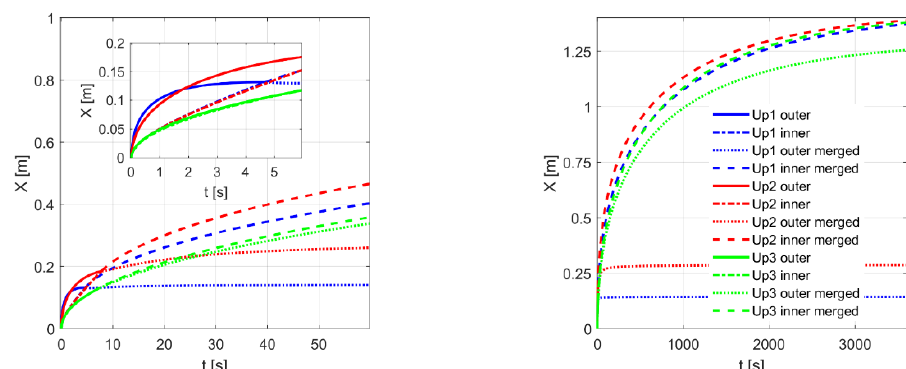
Figure 9. The height of water column [m] as a function of time [s] for cases Up1, Up2 and Up3, listed in Table 2. The graph panels represent two time intervals, 0–1 min and 0–1 h, respectively. The blue, red and green curves represent cases Up1, Up2 and Up3, respectively. Dashed and dotted lines represent the height of the water column after the merging of fronts.